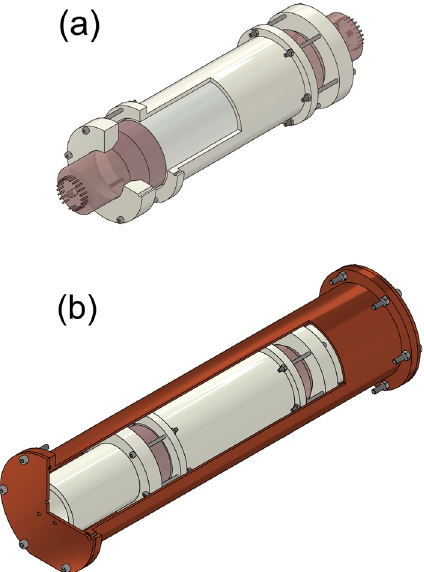
Fig. 17 Updated design of the NaI(Tl) detector encapsulation. a Inner structure for a mounting between the crystal and PMTs. b